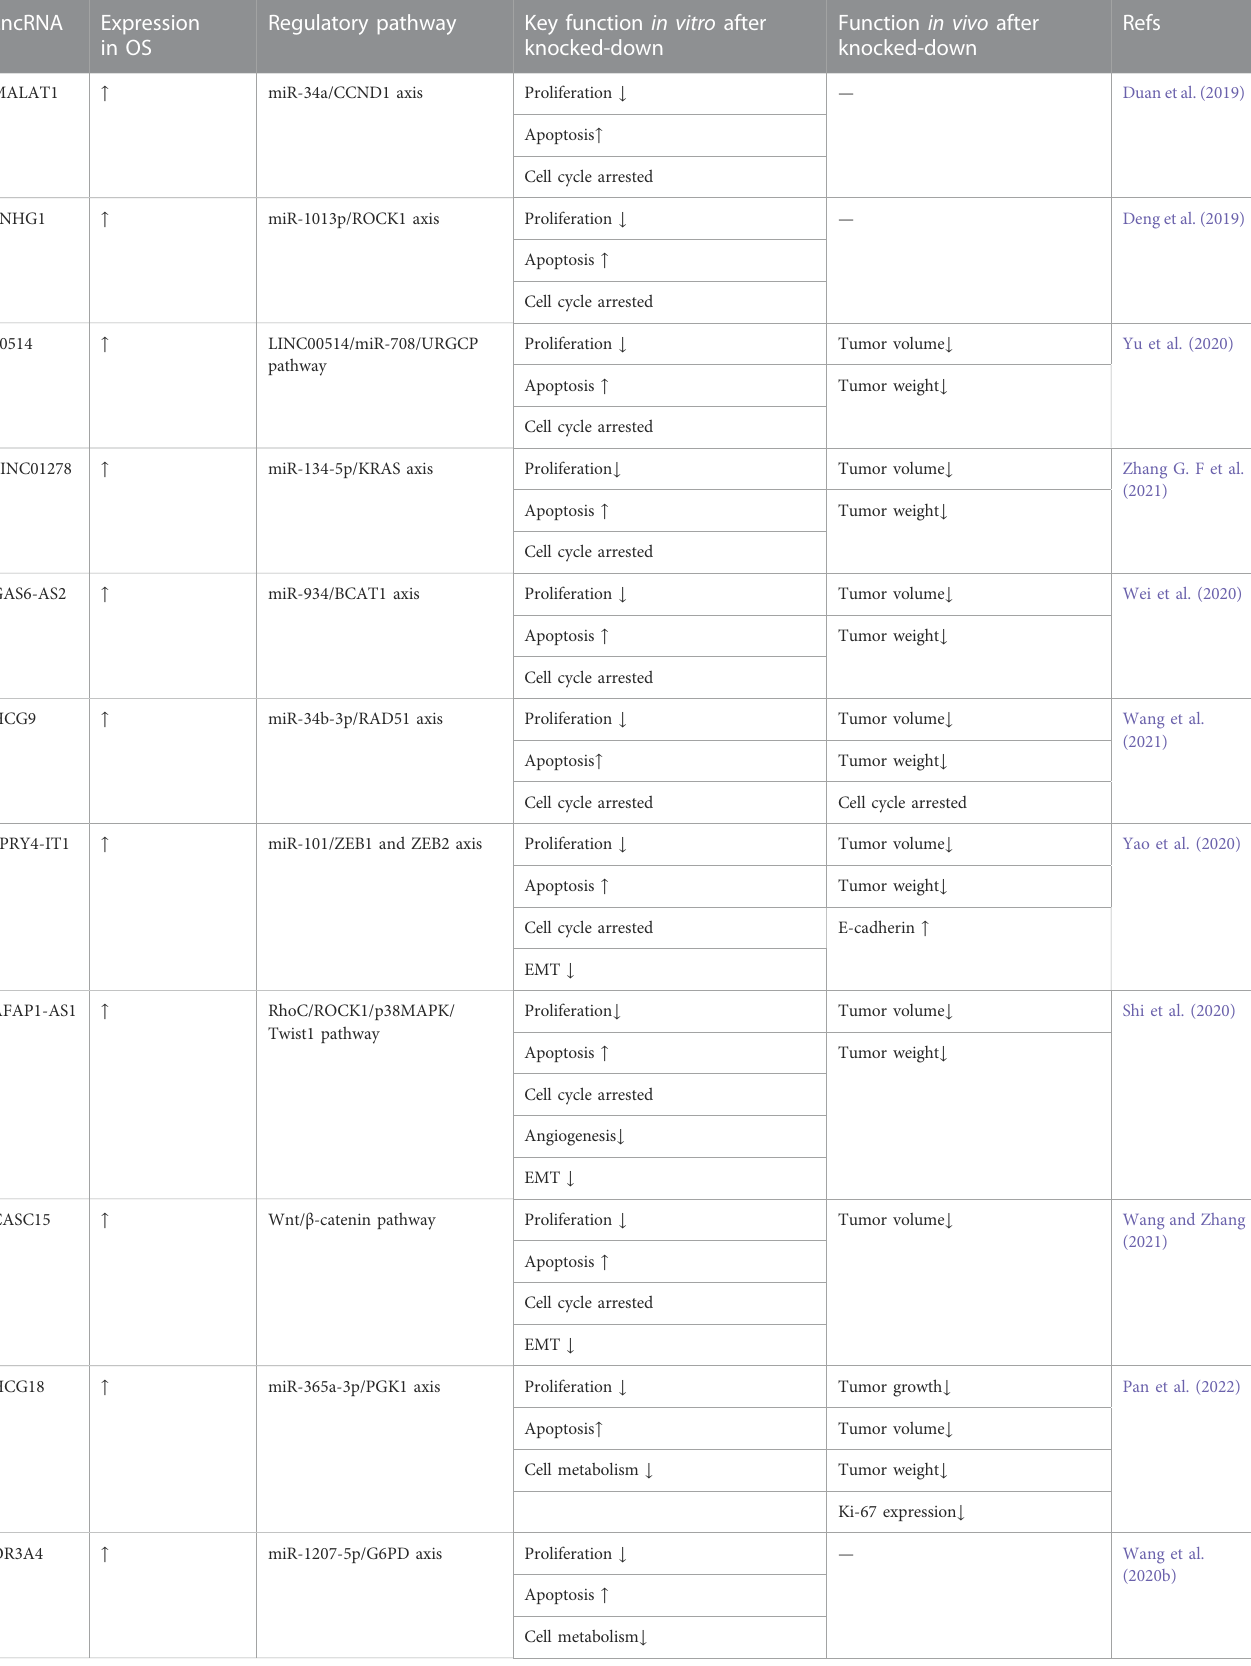
TABLE 2 Oncogenic lncRNAs associated with the cell cycle arrest of osteosarcoma cells.